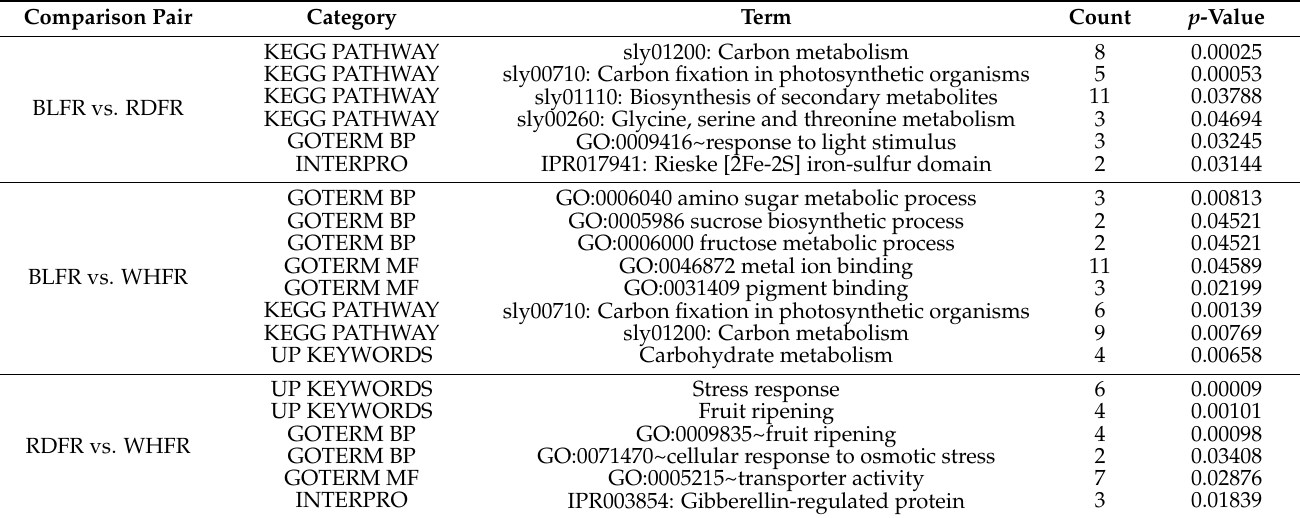
Table 1. Enrichment analysis of Differentially expressed genes in three comparison